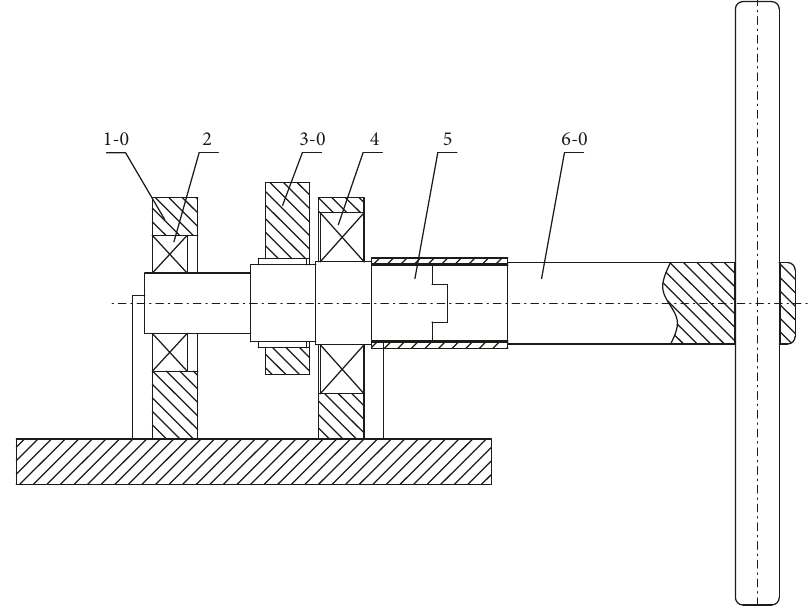
Figure 6: Structural diagram of the experiment apparatus. The numbered parts are as follows:1-0: bearing support, 2: rolling bearing 1, 3-0: bearing sample, 4: rolling bearing 2, 5: shaft, and 6-0: crank handle.